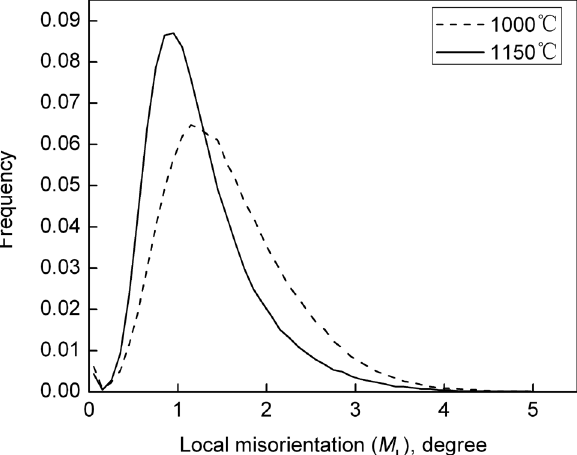
Fig. 5: Distribution of local misorientation with strain rate of 0.1 s − 1 at different temperatures (same data as in Fig. 4a and 4b).